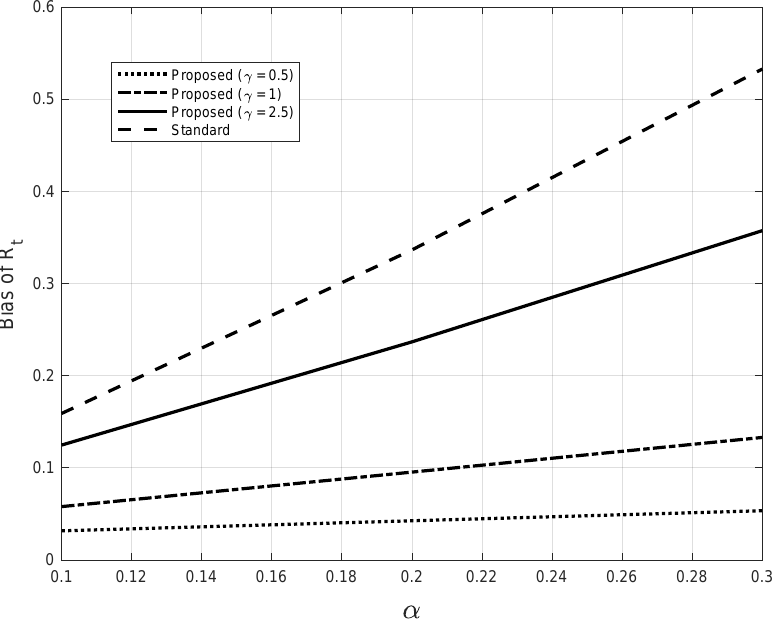
Figure 15. Bias of the R t estimated from the synthetic epidemic data, illustrated in Figure 14. The bias is plotted against the slope α . The dashed line corresponds to the estimate from the standard method. The other lines correspond to the proposed method, with three fixed values for the bandwidth γ in Equations (7), as indicated in the legend. The last value chosen is close to the one (2.7) found by the proposed method for the real SARS-CoV-2 Italian data from 21 September to 20 November 2020, illustrated in Figure